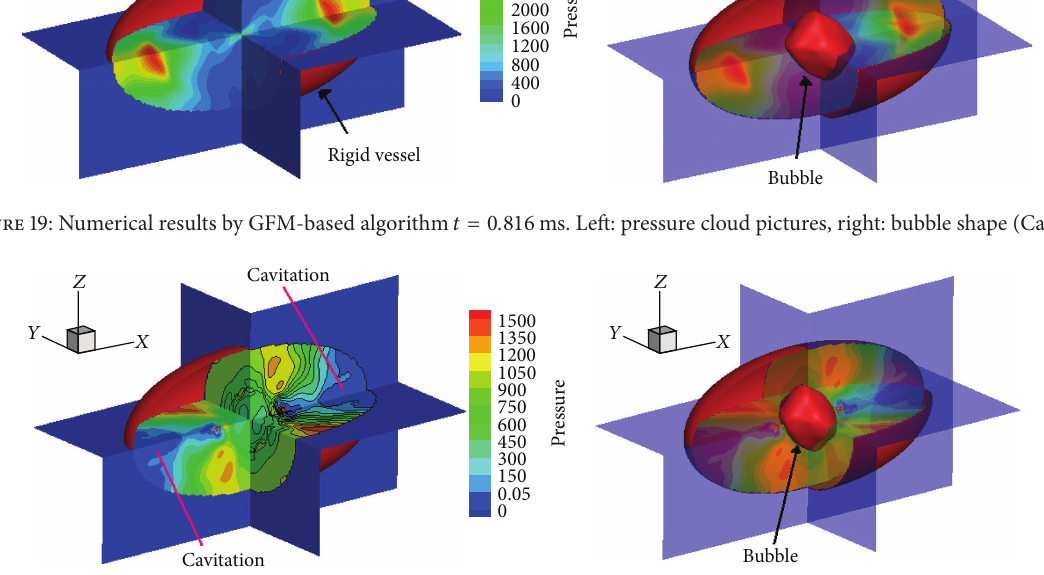
Figure 20: Numerical results by GFM-based algorithm 𝑡 = 10.466 ms. Left: pressure cloud pictures, right: bubble shape (Case